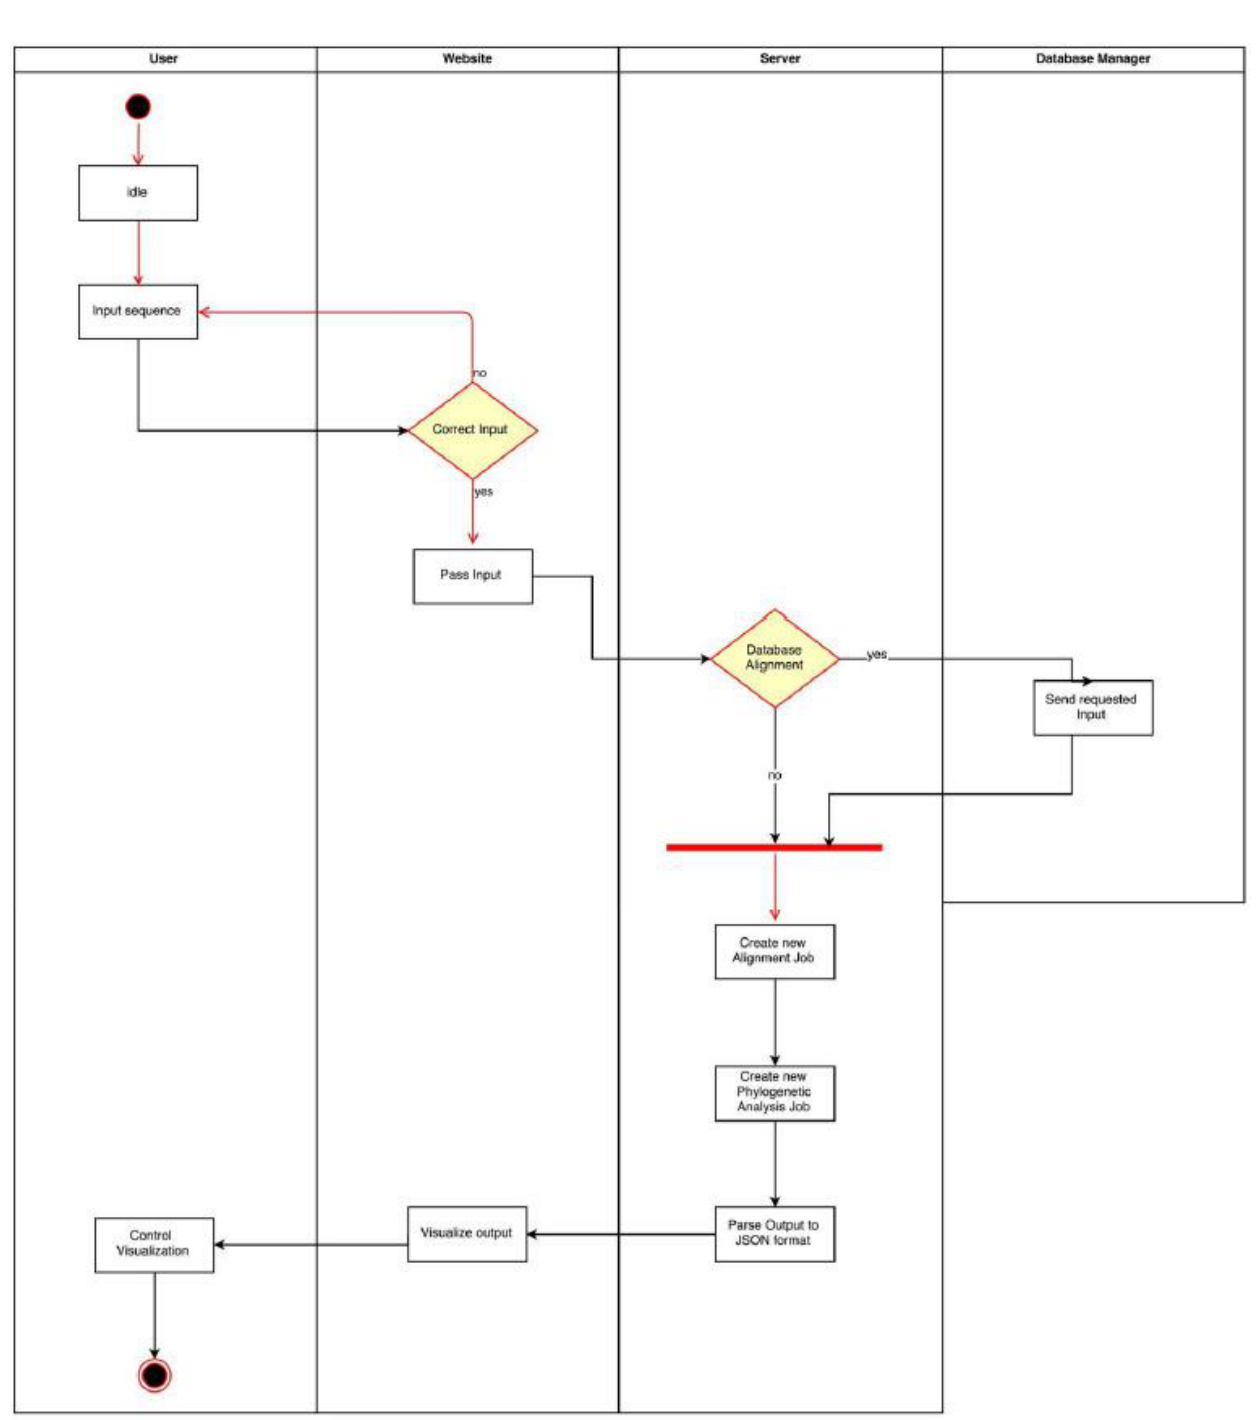
Figure 3. Activity diagram for the phylogenetic analysis module.